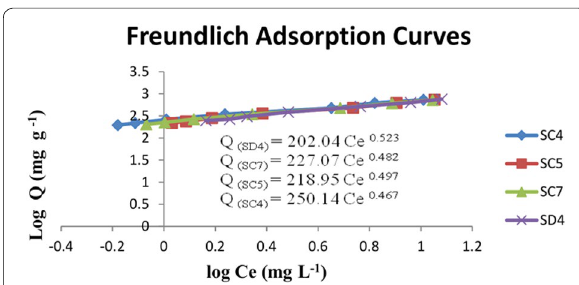
Fig. 7 Freundlich adsorption curves and equations for SC4, SC5, SD7, and SD4 soils